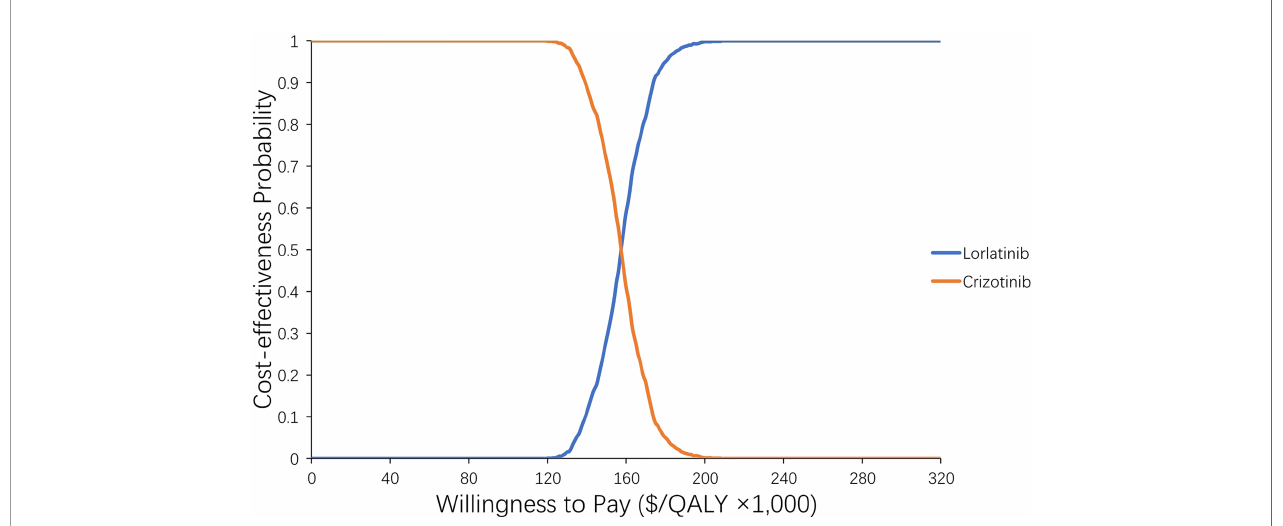
FIGURE 4 | Acceptability curve of the probability sensitivity analysis. The probability sensitivity analysis of scenario 3-2 (adjusting the price of lorlatinib to its lower